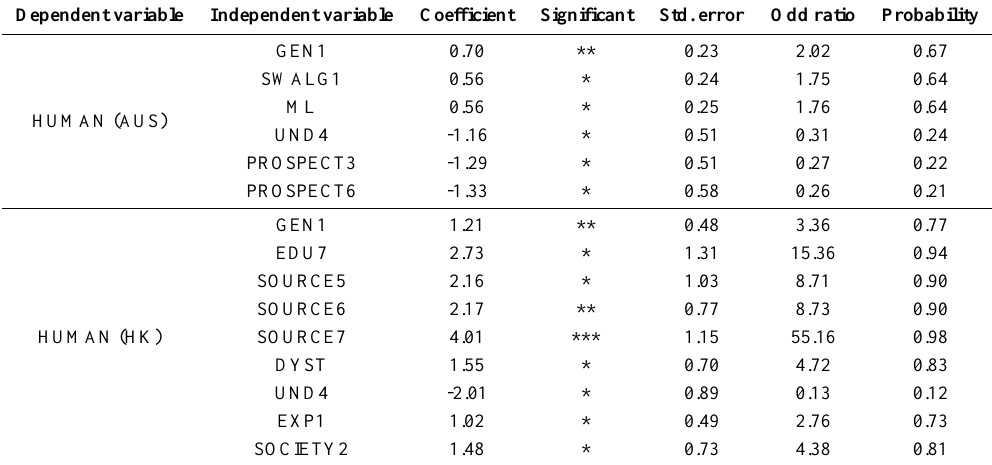
Table B-11. Limited human oversight over AI decisions concerning the local community Dependent variable Independent variable